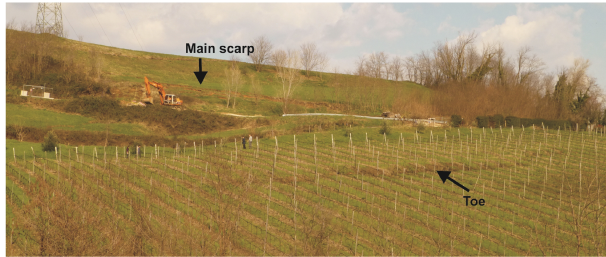
Figure 2. View of Carrè